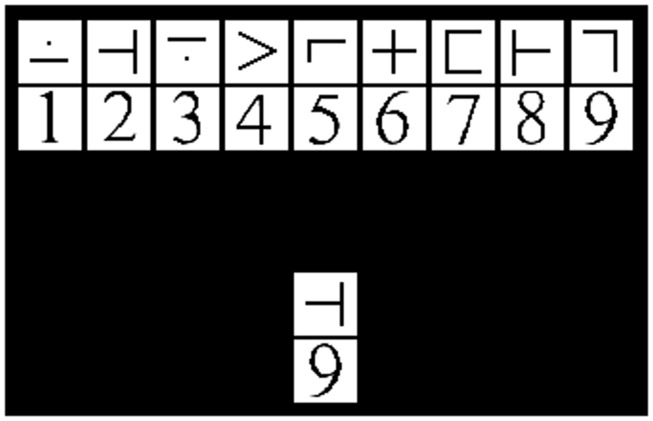
Example of the stimuli used during the mSDMT. Target represents a no-match trial.